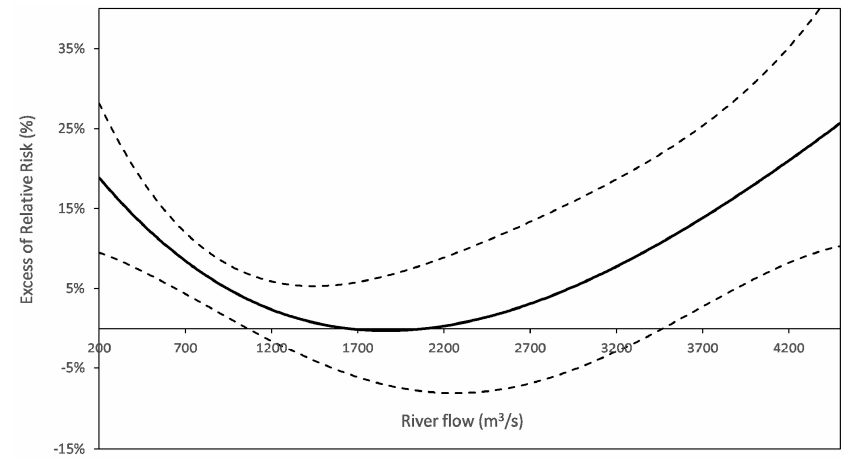
Figure 4. AGE risk function for the river flow (Nantes). The right branch may miss (e.g., PA sites). The delay considered for the health response to the river flow is homogenous with that used for turbidity.